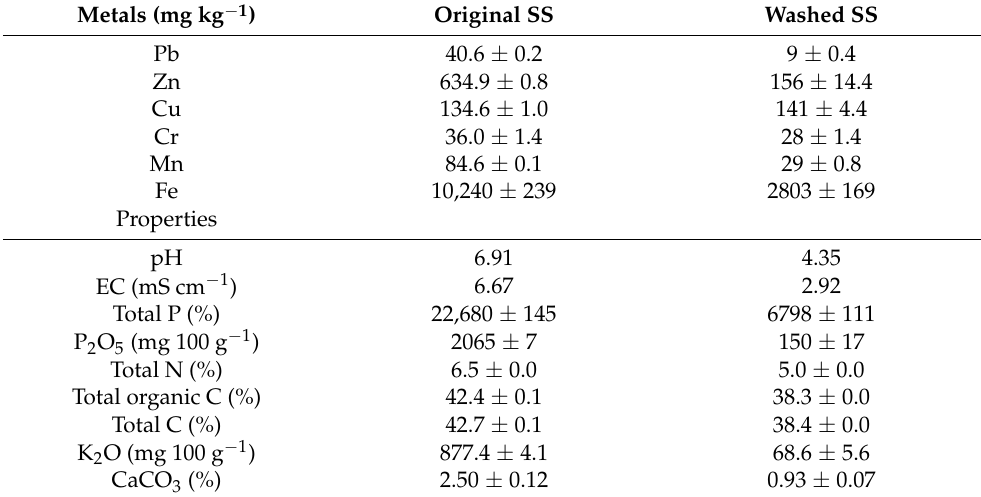
Table 1. Metal concentrations and properties of original and washed sewage sludge (SS) after acid hydrolysis coupled with EDTA. Data for metal concentrations in original SS are given as the average ± standard error of three subsamples taken from the homogenized bulk, and for washed SS as the calculated average from batches 1–5. Properties of original SS refer to the homogenized bulk sample, and washed SS to the combined sample from batches